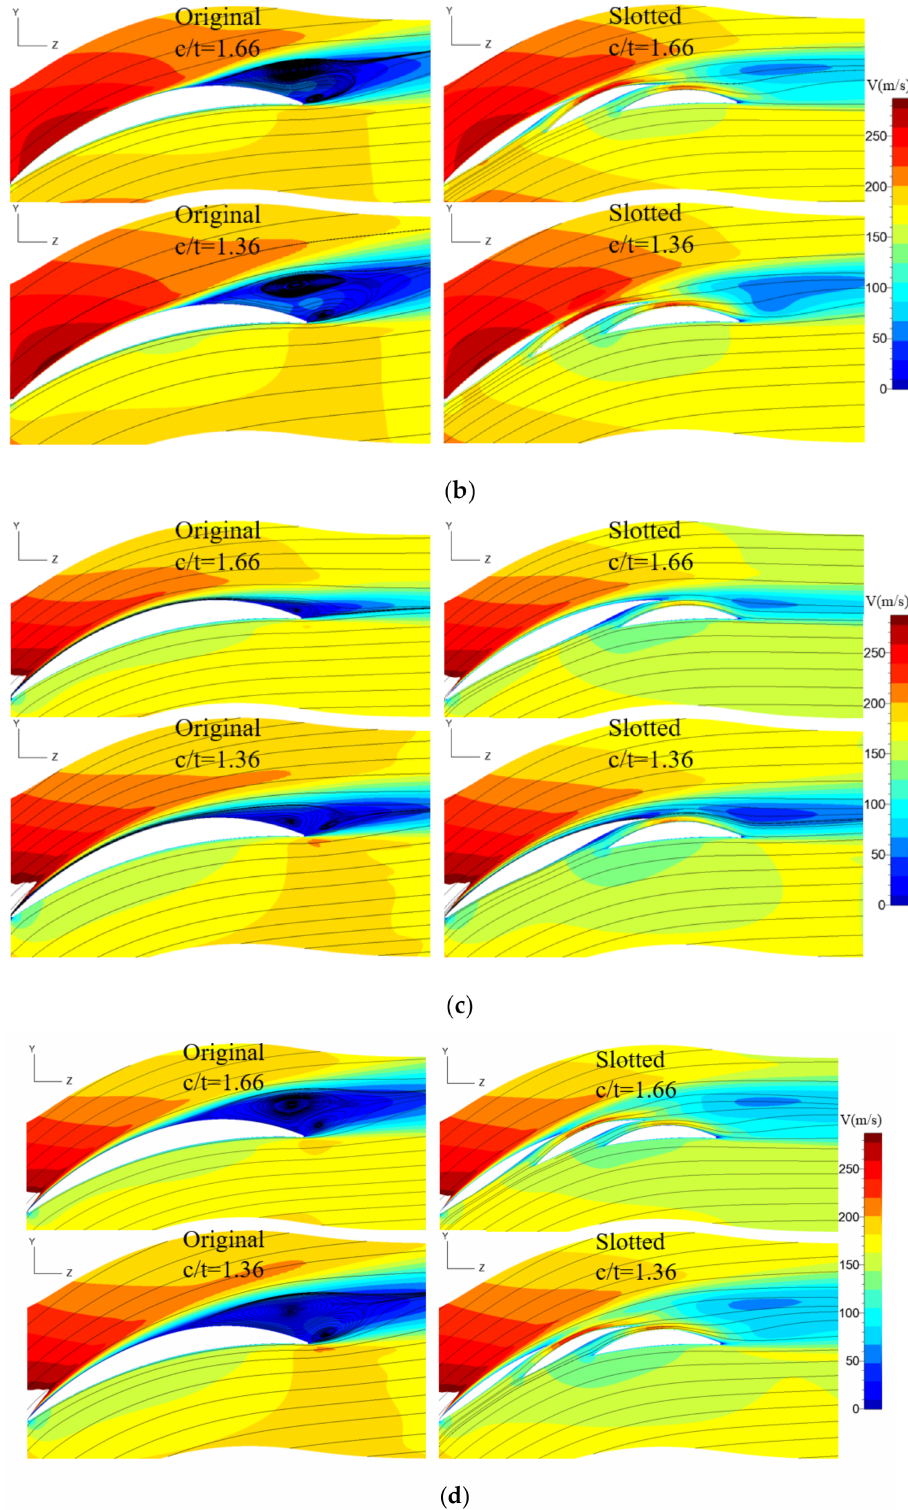
Figure 8. Streamlines and velocity contours of the original cascade and combined slotted cascade: ( a )